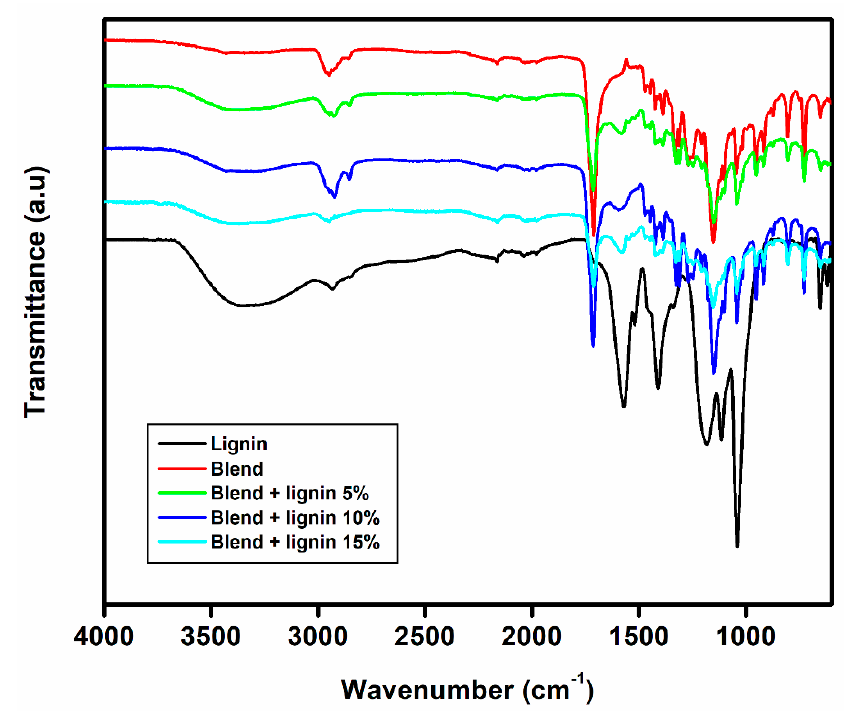
Figure 2. FTIR spectra of lignin, polymer blends, and composites.